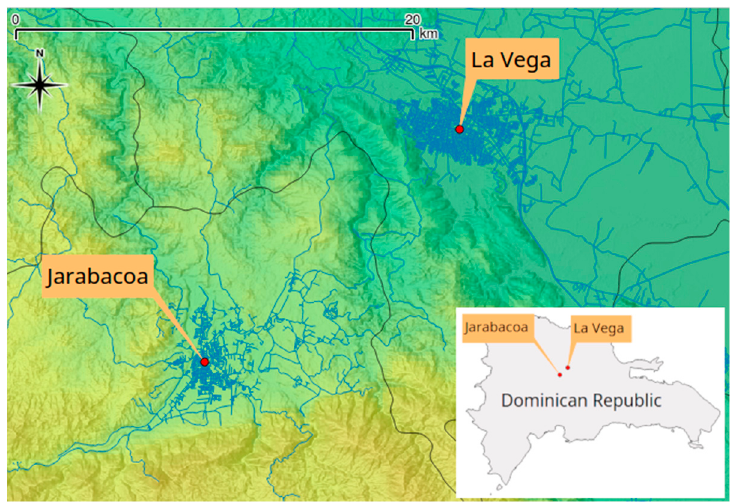
Figure 1. Location of the study area of Jarabacoa, province La Vega, D.R. Cartography licensed under